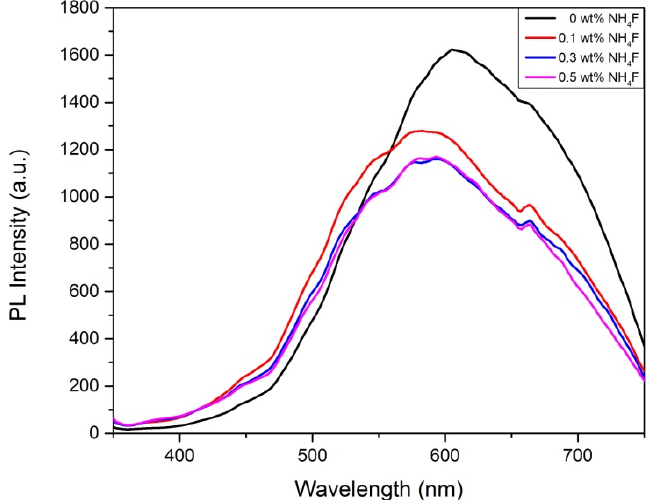
Figure 5. Smooth PL curve for WO 3 -TiO 2 nanotubes produced with different fluoride ion